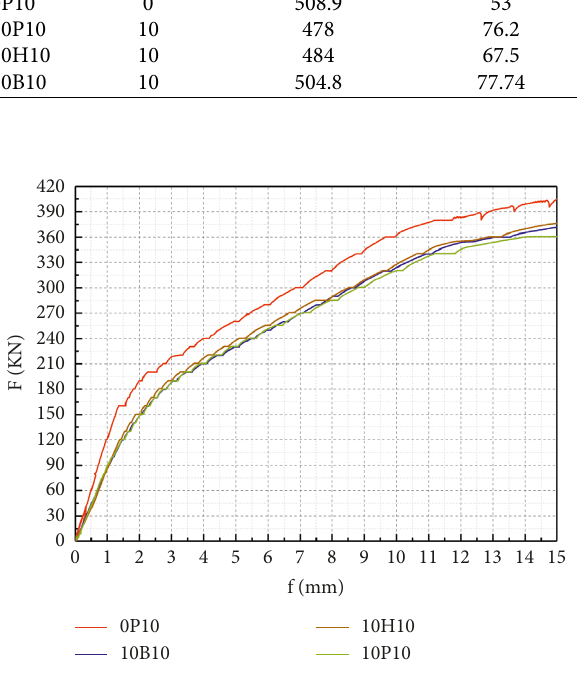
Figure 13: Stiffness at an earlier stage of